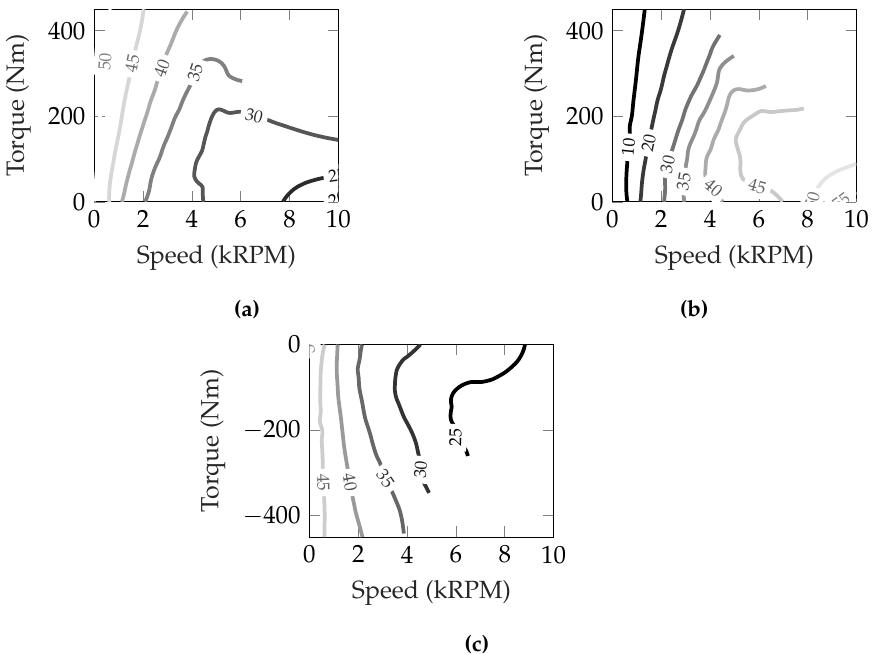
Figure 6. Loss distribution in percent of: motoring traction drive ( a ), mechanical transmission ( b ), and generating traction drive ( c ). The loss of the mechanical transmission is assumed to be symmetrical with regards to positive and negative torque.